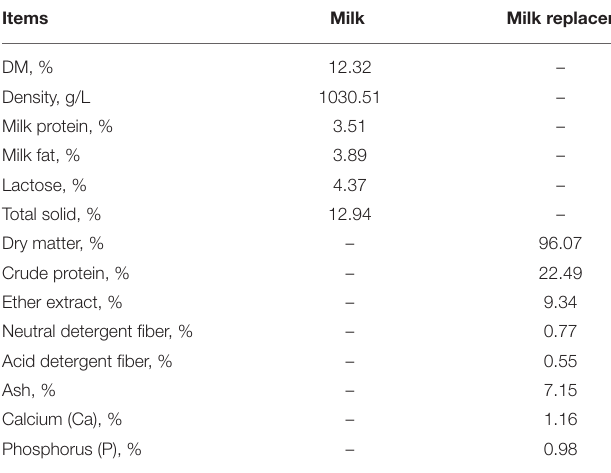
TABLE 3 | Chemical analysis of milk and milk replacer (MR) fed to Holstein heifer calves during the suckling period from birth to 60 days after calving a